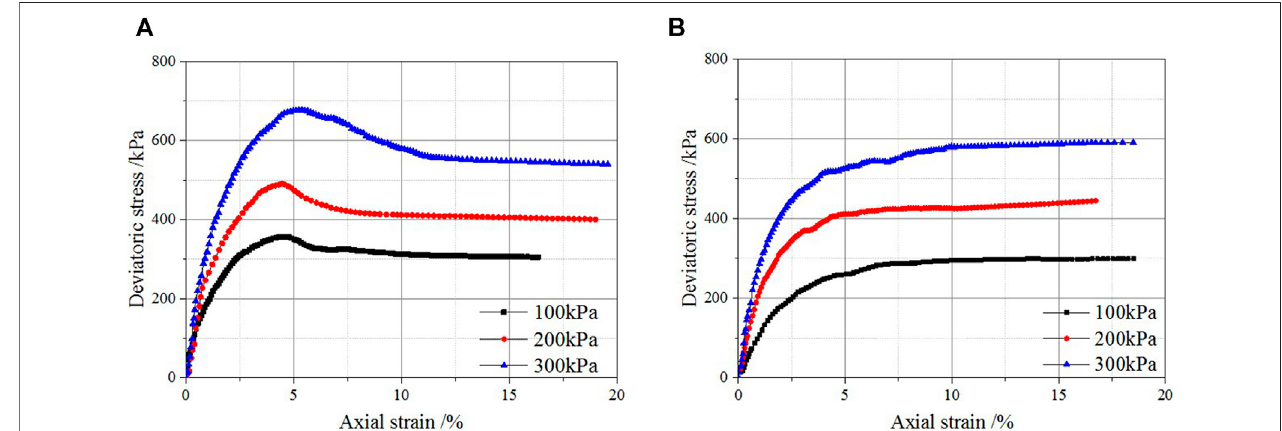
FIGURE 3 | Stress-strain curves at different con fi ning pressures: (A) original specimens; (B) F-T specimens.